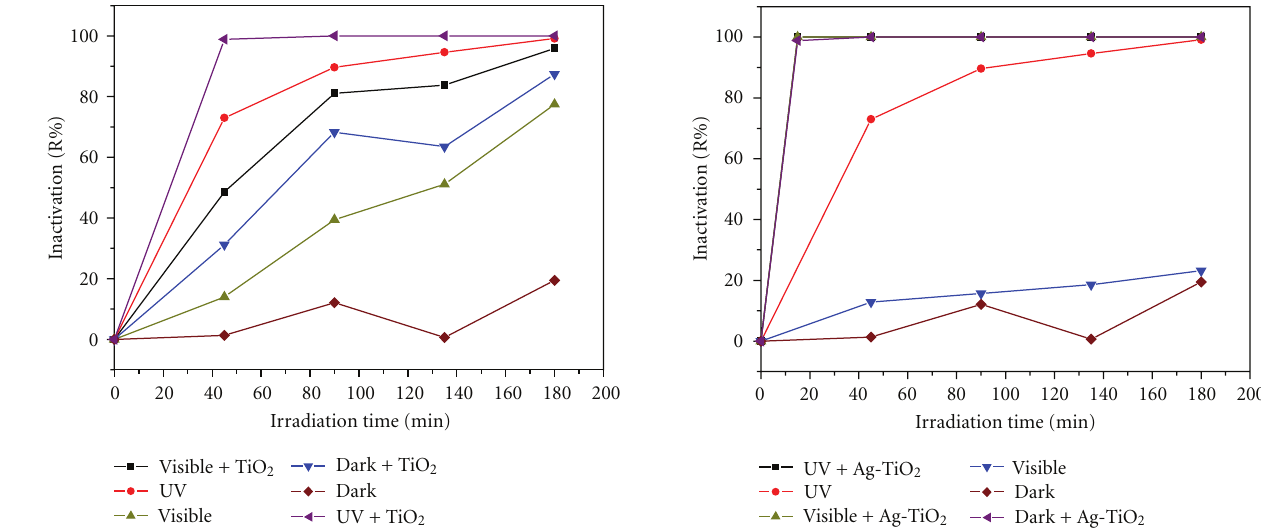
Figure 7: R percentage versus irradiation time of di ff erent light sources using Ag-TiO 2 as